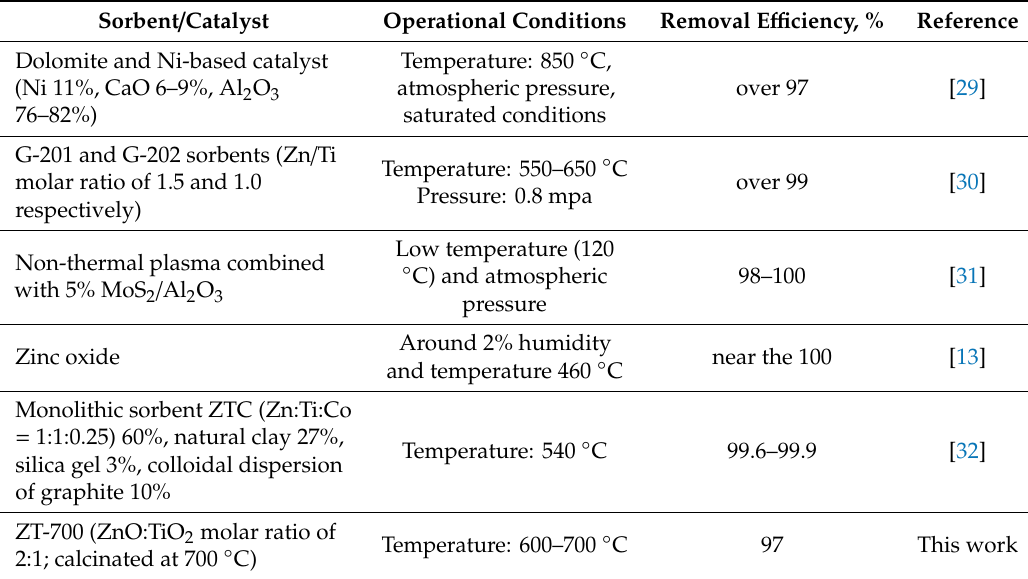
Table 3. Comparative study on the e ffi ciency of H 2 S removal from syngas. Values were obtained in the best operation